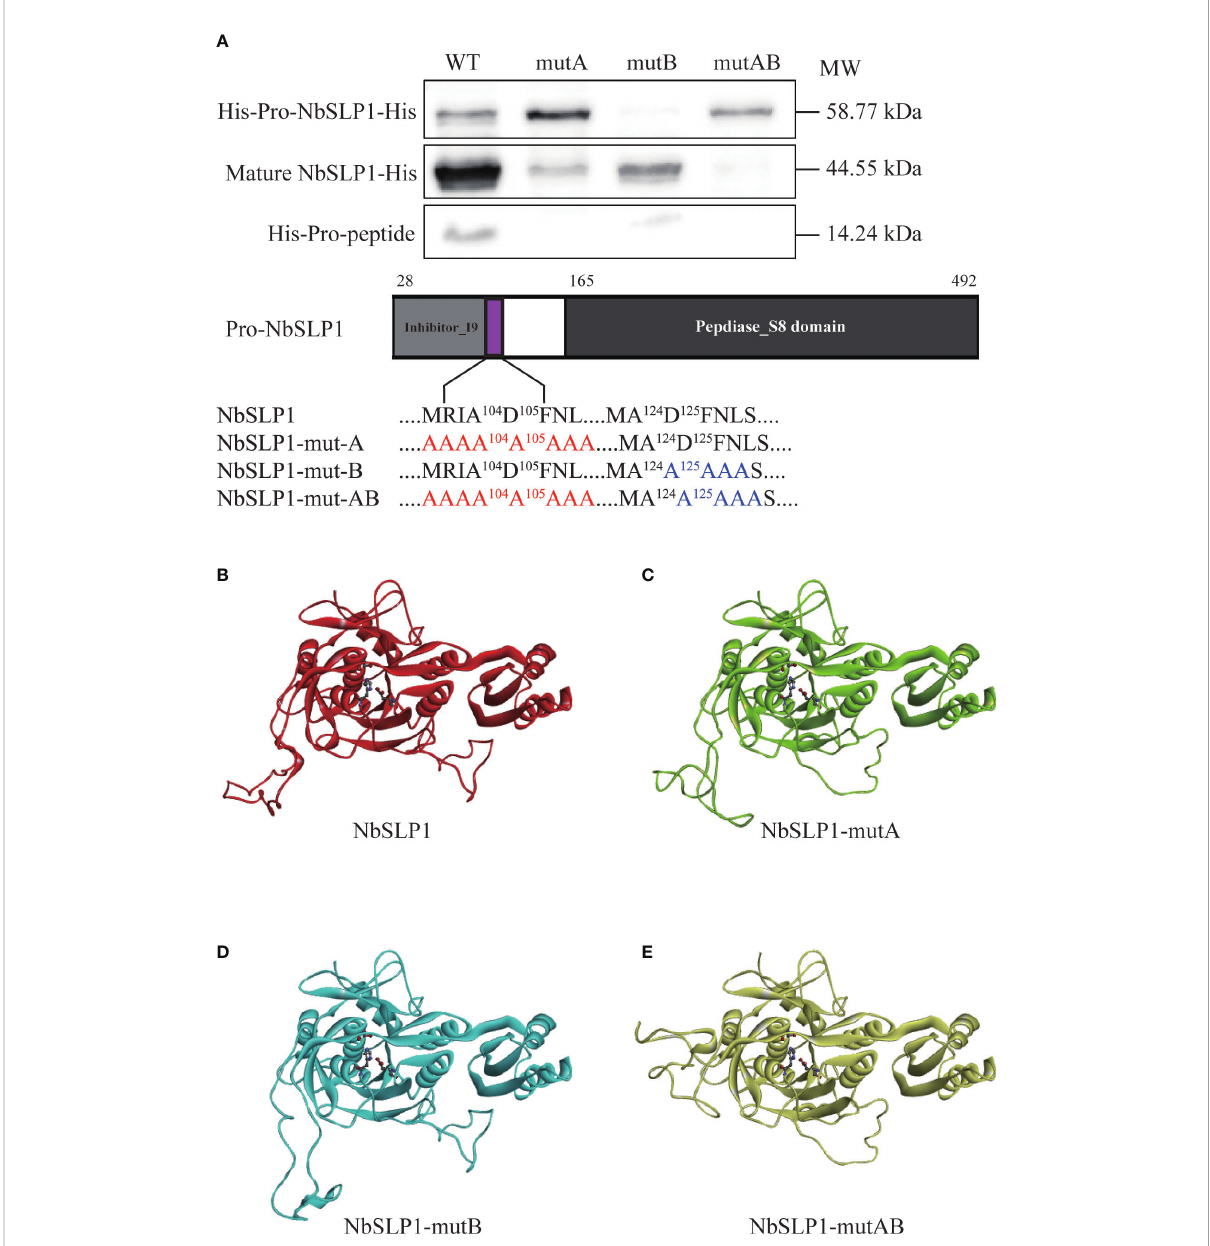
FIGURE 4 Autoproteolysis analysis of Pro-NbSLP1 mutants in cleavage sites and predicted 3D structure. (A) Western blot analysis of Pro-NbSLP1 mutants. Supernatant from induced E . coli BL21 (DE3) [pET30- Pro - Nbslp1 ] (WT), E . coli BL21 (DE3) [pET30- Pro - Nbslp1-mutA ] (mut A), E . coli BL21 (DE3) [pET30- Pro - Nbslp1-mutB ] (mut B), E . coli BL21 (DE3)[pET30- Pro - Nbslp1-mutAB ] (mut AB) were analyzed by immunoblotting using His antibody. Strategy of mutants was showed below. Predicted 3D structure of NbSLP1 and its mutants against Pro-subtilisin E (PDB: 3whi.1) are showed in B – E ; unmutated NbSLP1 is showed in red ribbon (B) , NbSLP1-mut A is showed in green ribbon (C) , NbSLP1-mut B is showed in light blue ribbon (D) , NbSLP1-mut-AB is showed in yellow ribbon (E)